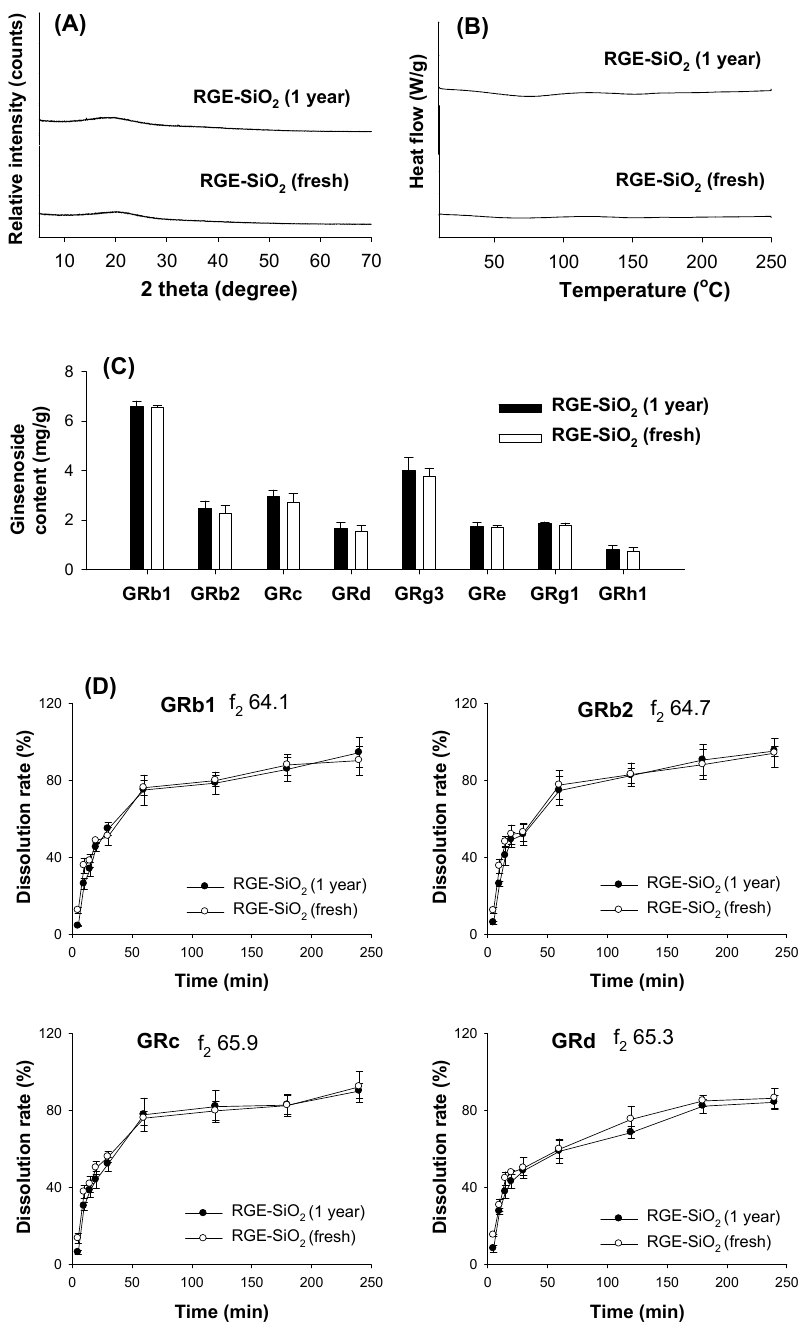
Figure 9. ( A ) The X-ray diffraction patterns and ( B ) the differential scanning calorimetry thermogram of the solid dispersion of RGE-SiO 2 stored for 1 year compared with freshly prepared RGE-SiO 2 . ( C ) Ginsenoside content detected in the solid dispersion of RGE-SiO 2 stored for 1 year compared with freshly prepared RGE-SiO 2 . Data represent the mean ± standard deviation ( n = 4). ( D ) Dissolution profiles of ginsenoside GRb1, GRb2, GRc, and GRd from the solid dispersion of RGE-SiO 2 stored in thermo-hygrostat (25 °C, 30% RH) for 1 year compared with freshly prepared RGE-SiO 2 were measured using the paddle method for 240 min. Data represent the mean ± standard deviation ( n = 12), and the similarity factor ( f 2 ) was calculated from the mean dissolution values of GRb1, GRb2, GRc, and GRd at time points from 5 min to 180 min.